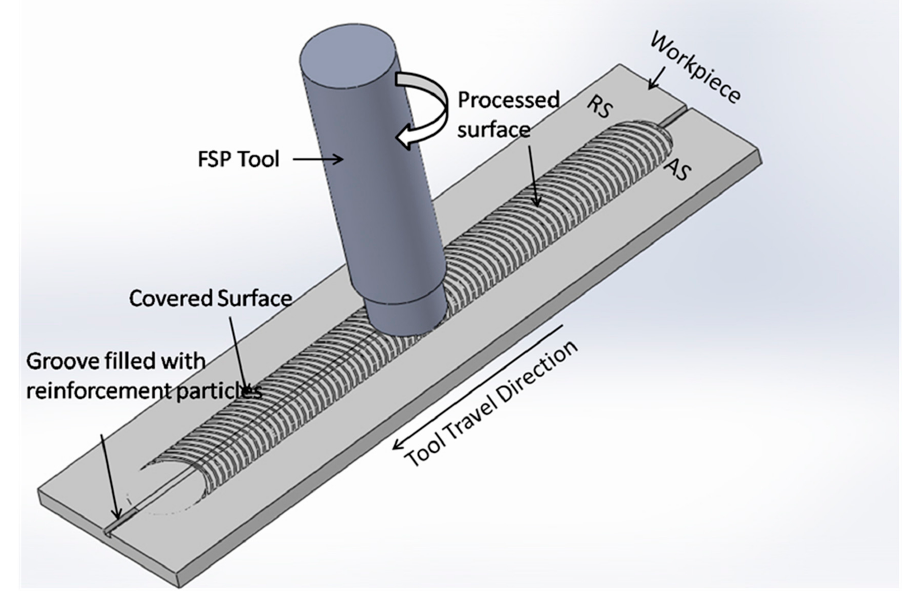
Figure 1. Schematic diagram of friction stir processing.